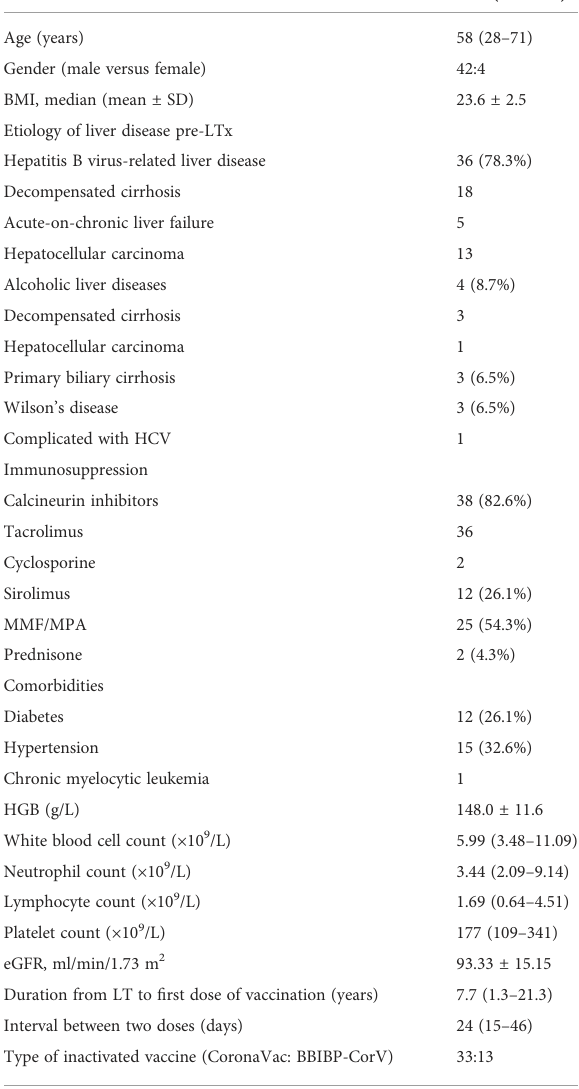
(Figure 2B; Spearman ’ s r = 0.818, p < 0.001). Additionally, NPI was correlated with anti-S1S2 level (Figure 2C; Spearman ’ s r = 0.511, p <